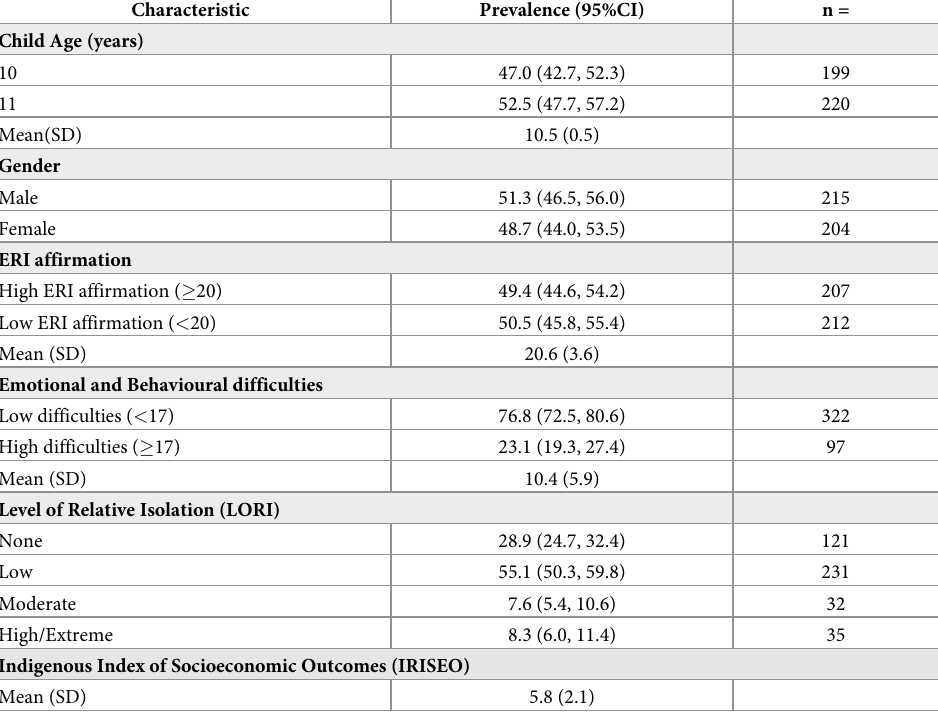
Table 4. Participant’s characteristics (n =